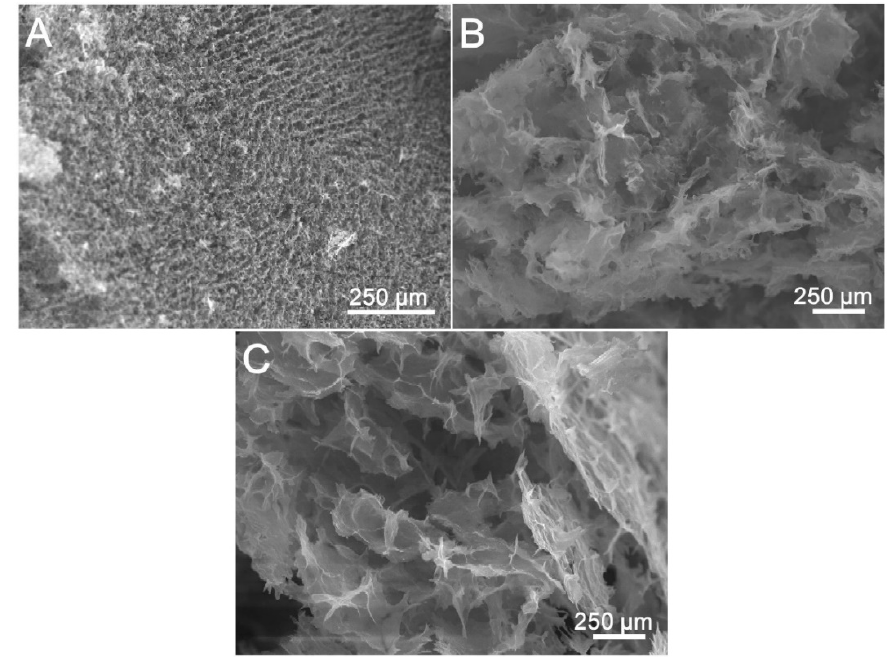
Figure 4. SEM images of GO-COOH cryogels modified with: ( A ) ethylenediamine (EDA) ( B ) diethylenetriamine (DETA) and ( C ) triethylenetetramine (TETA).